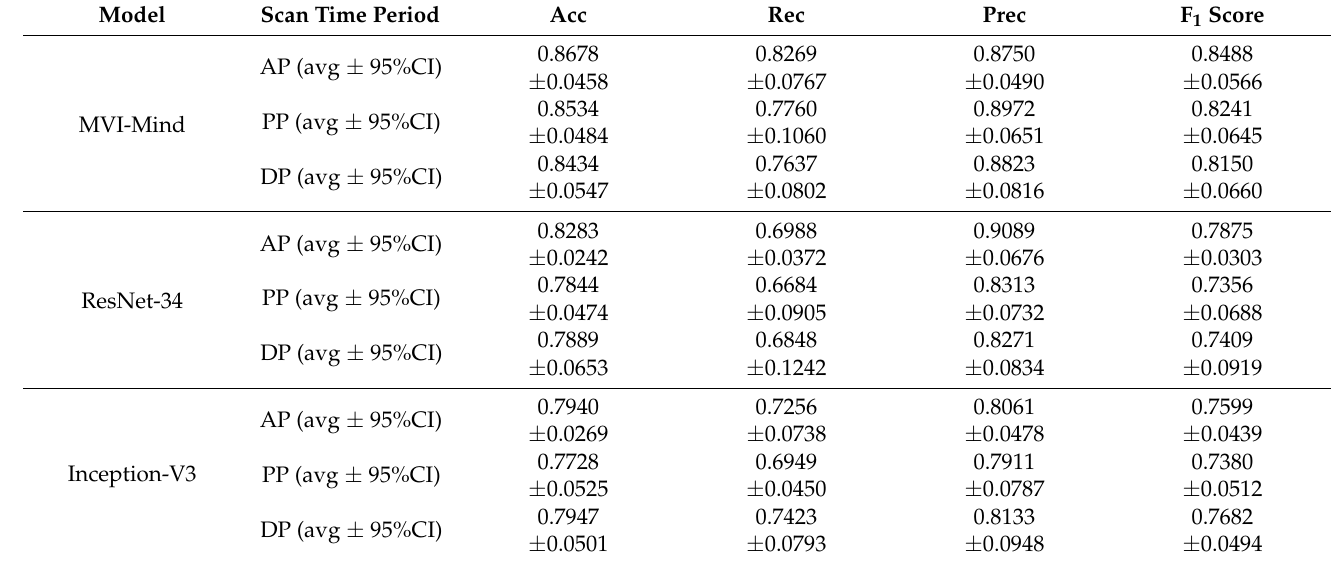
Table 6. The performance of each deep learning model in the MVI prediction task.